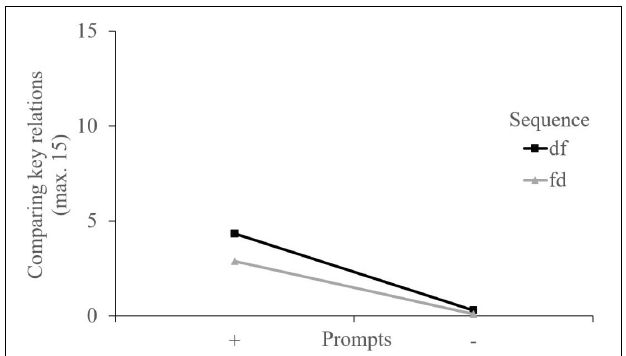
FIGURE 4 | Interaction plot regarding comparing key